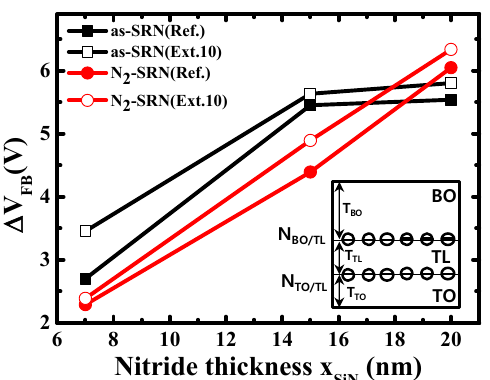
Figure 6. Extracted results of V FB shift in capacitance-voltage curve according to the trapping layer thickness. Inset shows the oxide / trapping layer interface trap sites in the SONOS device structure.